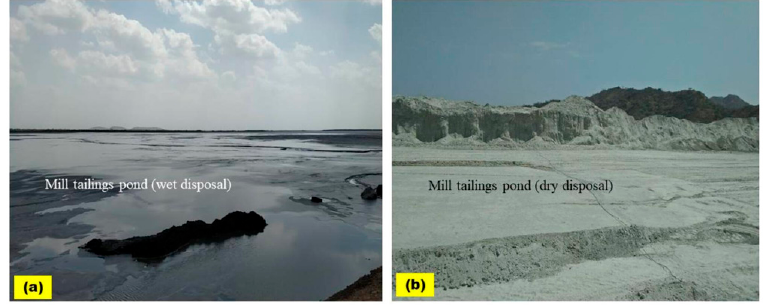
Figure 1. Surface disposal of tailings: ( a ) Wet disposal and ( b ) dry disposal.